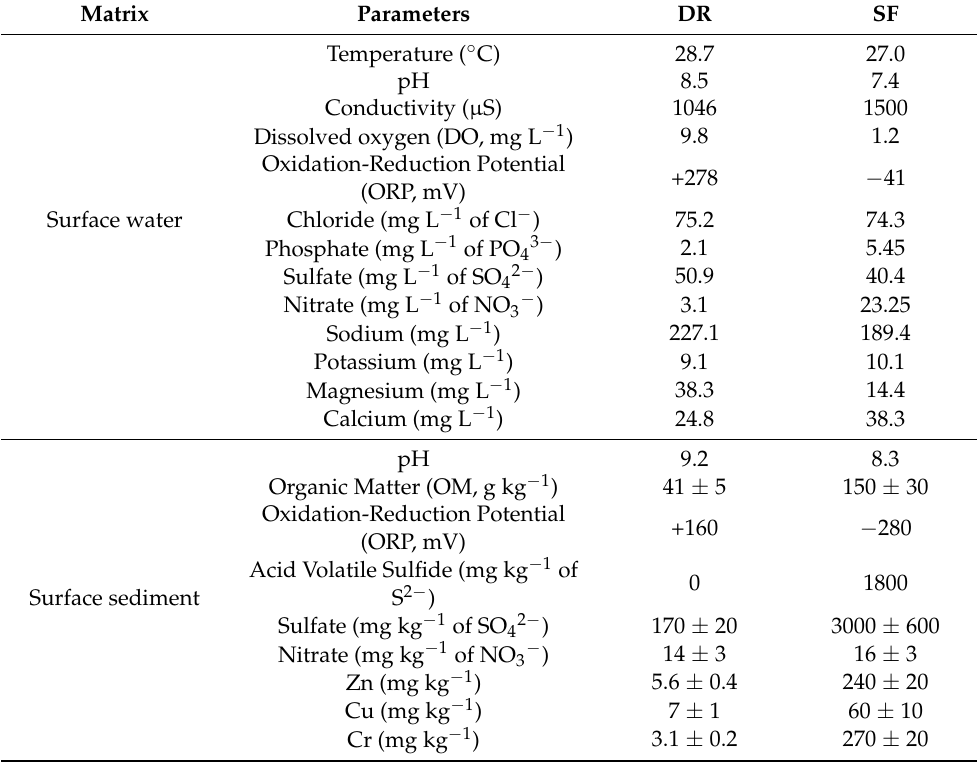
Table 1. Physicochemical parameters measured in the surface waters and sediments of the Dique